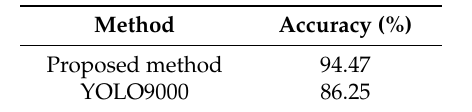
Table 3. Accuracy of standing-pig detection.